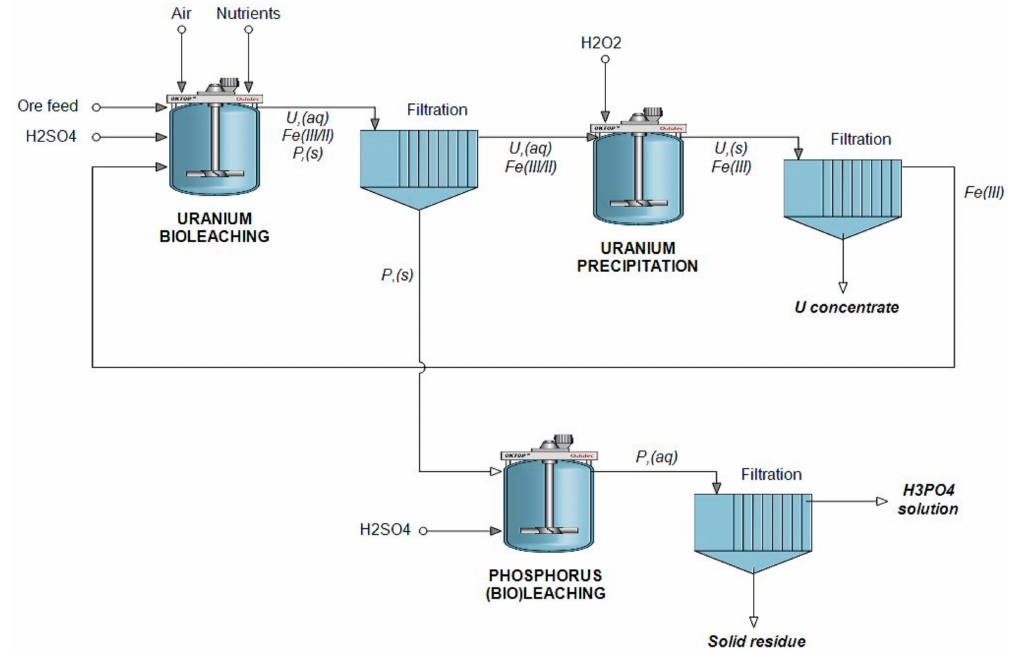
Figure 6. Proposed flowsheet of the sequential bioleaching of phosphorus and